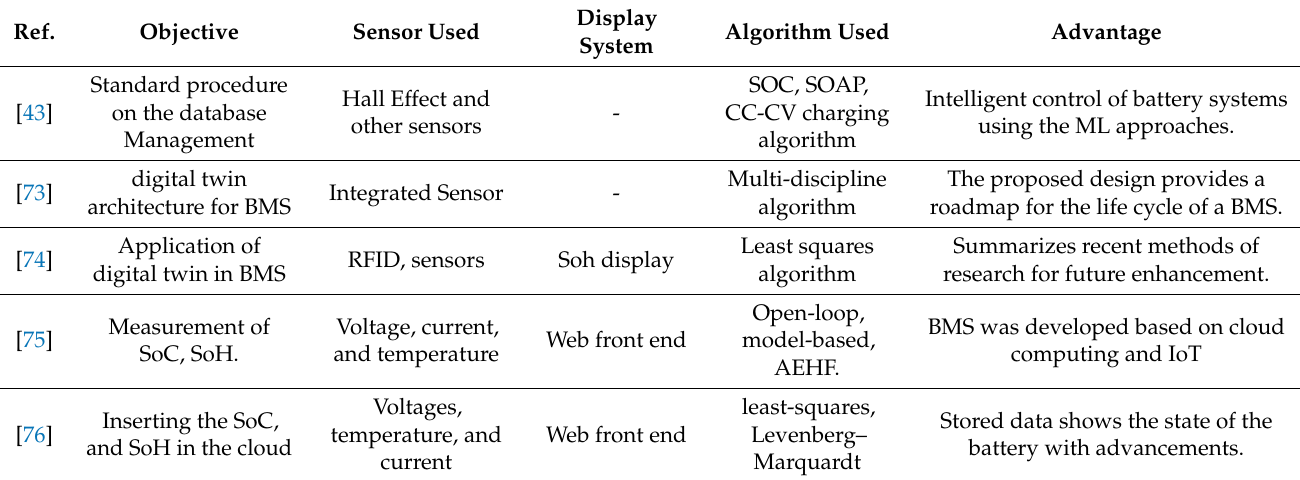
Table 8. A survey on digital twins in battery-management